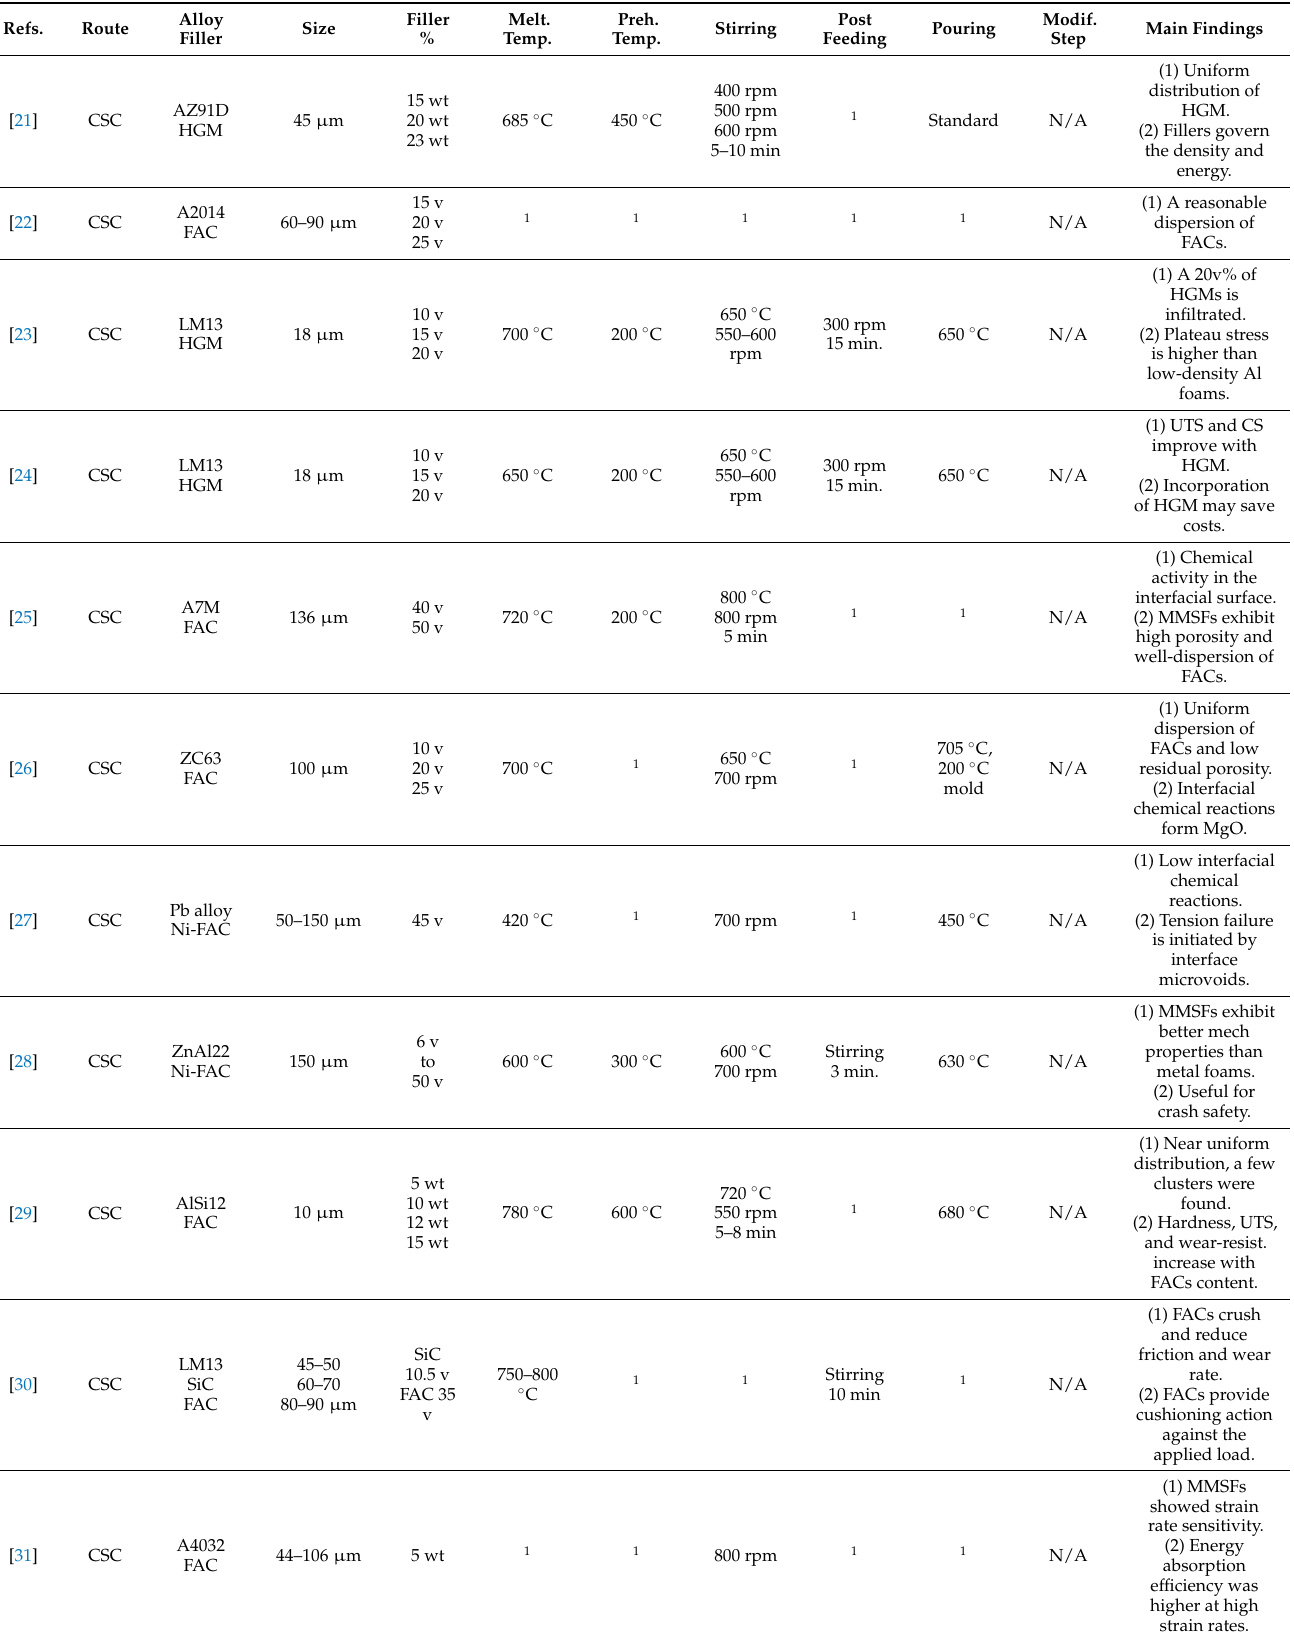
Table 1. Studies’ routes, matrices, fillers, processing parameters, and main findings.